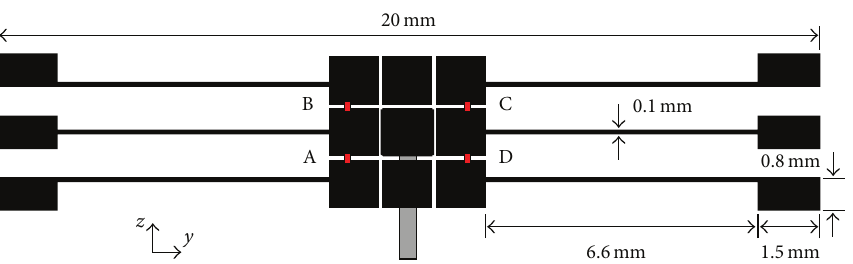
Figure 9: Fragment of the top layer geometry for the antenna with bias lines feeding network. The antenna total substrate size is 20 mm by 40